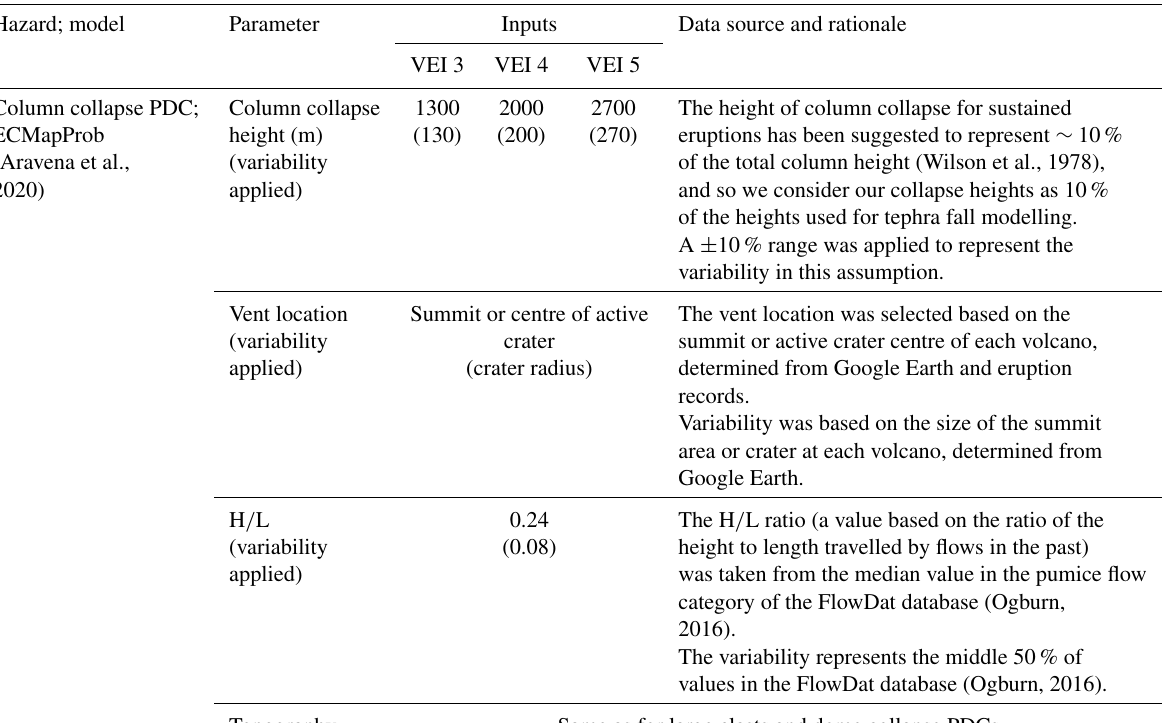
Table A4. Model input parameters and their rationale used for simulating column collapse PDCs. Hazard; model Parameter Inputs Data source and rationale VEI 3 VEI 4 VEI 5 Column collapse PDC; Column collapse 1300 2000 2700 The height of column collapse for sustained ECMapProb height (m) (130) (200)